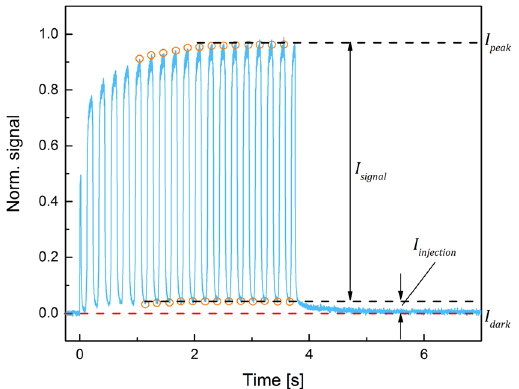
Figure 2. Response of PbO detector to the modulated X-ray exposure at F = 2 V/ μ m. It should be noted that first points at the beginning of the exposure are affected by non-synchronization of the chopper with exposure and fluctuations in X-ray intensity at the beginning of the X-ray pulse.